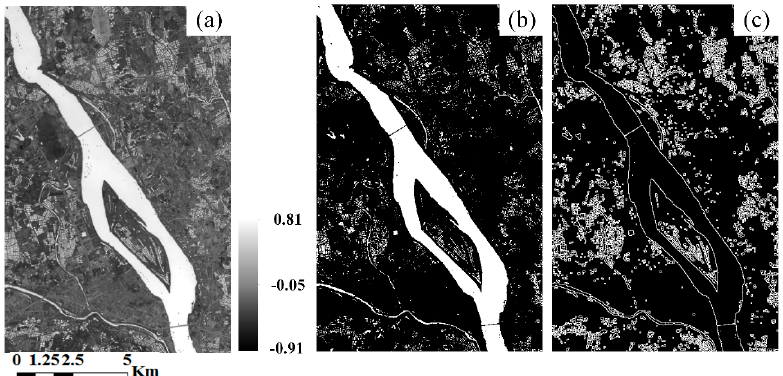
Figure 4. Pure water and mixed water-land pixels for Region B: ( a ) normalized difference water index (NDWI) image of green and SWIR1 bands; ( b ) pure water pixels (white) of NDWI with a 0.114 threshold; and ( c ) mixed water-land pixels (white).